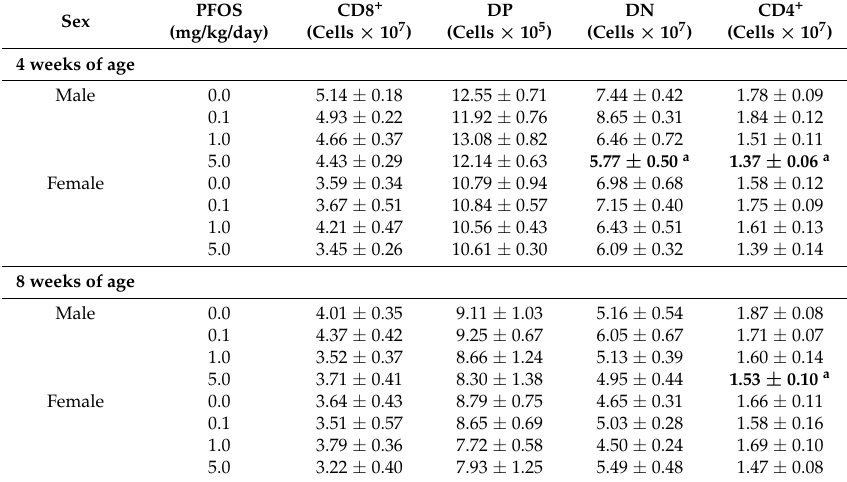
Table 3. Thymic lymphocyte sub-populations in C57BL6 mice exposed in utero to PFOS during GD 1–17.